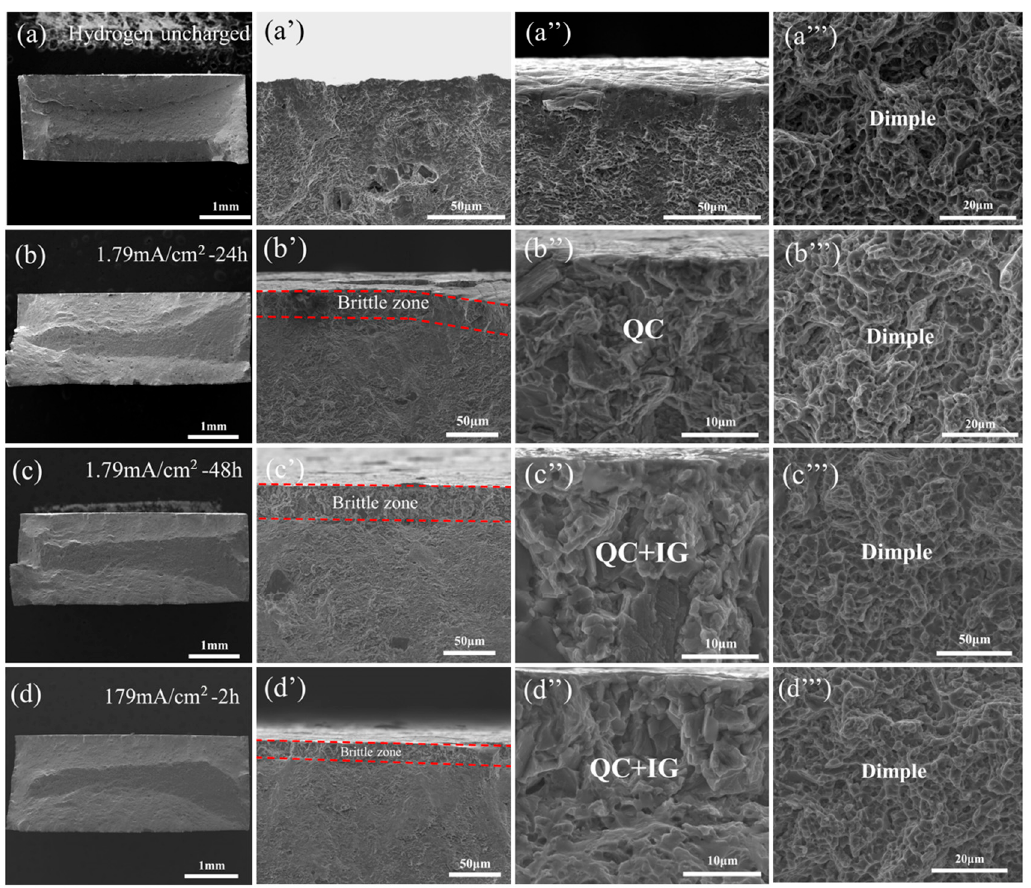
Figure 6. SEM images of fractured hydrogen-charged and uncharged samples of IN718 subjected to various hydrogen charging parameters viewed from top side. ( a – a ′′′ ) uncharged; ( b – b ′′′ ) 1.79 mA cm − 2 for 24 h; ( c – c ′′′ ) 1.79 mA cm − 2 for 48 h; ( d – d ′′′ ) 179 mA cm − 2 for 2 h. IG: intergranular fracture; QC: quasi-cleavage fracture. Table 3. Brittle zone depth of hydrogen-charged CoCrFeMnNi, 304 SS and IN718 alloy. Hydrogen Charging Parameters